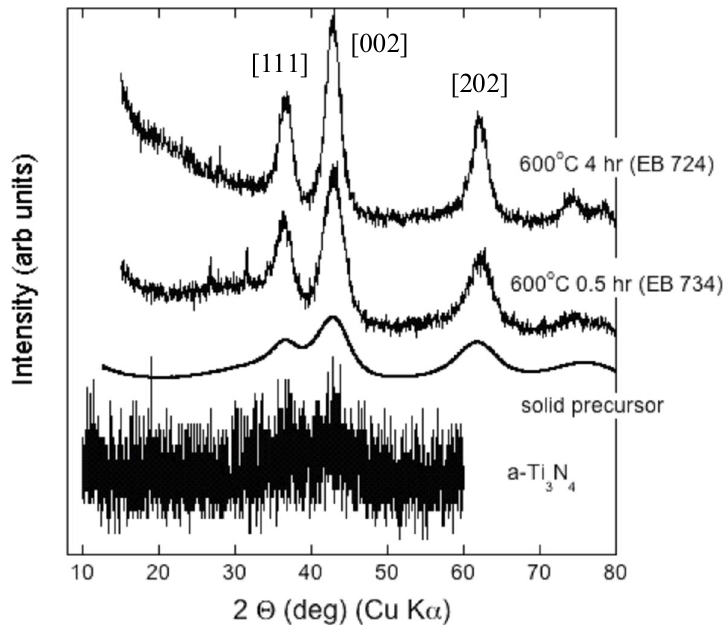
Figure 5. X-ray diffraction results for Ti nitride samples following high-P,T treatment compared with the amorphous powdered a-Ti N starting material obtained by the 3 4 chemical precursor route. The patterns for a-Ti N and EB samples were obtained using 3 4 laboratory instruments at Southampton University and University College London (UCL) respectively. The solid precursor pattern was obtained for a sample densified at ambient T in a diamond anvil cell at beamline I15 of the Diamond synchrotron (Chilton, UK) using an incident beam with  = 0.442Å (A. Salamat, unpublished). All data are plotted vs. 2  values calculated for Cu K radiation. 